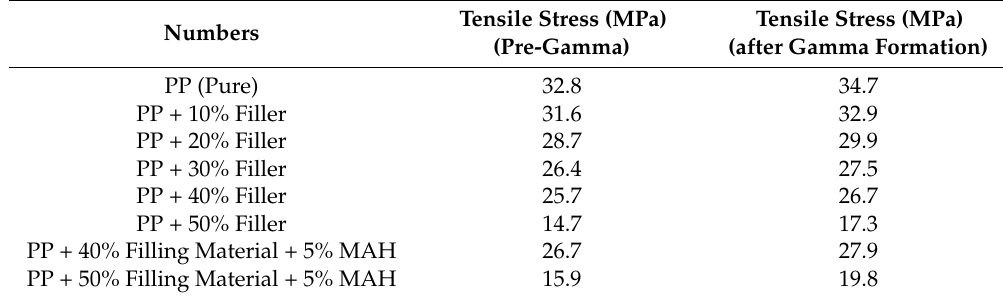
Table 4. Comparative presentation of polypropylene matrix specimens tensile stress findings before and after radiation exposure.